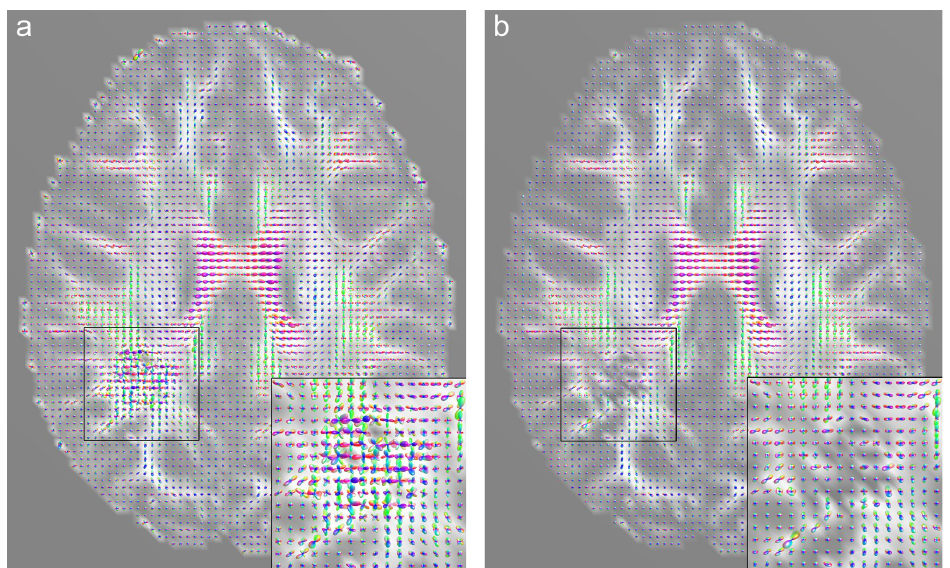
Fig 1. Effect of denoising DW-MRI data from patient B on CSA-ODFs. To provide anatomic context, GFA slice images are used as the background for the CSA-ODF glyphs. Images (a) and (b) both show the same slice, calculated with Matlab. The marked and enlarged areas show the tumor region inside the right hemisphere. (a) CSA-ODFs calculated from noisy DW-MRI data. (b) CSA-ODFs calculated after application of the OLPCA noise reduction scheme. Noise reduction was applied to the entire DW-MRI dataset but is most effective in regions with a low SNR, such as the marked and enlarged tumor region.